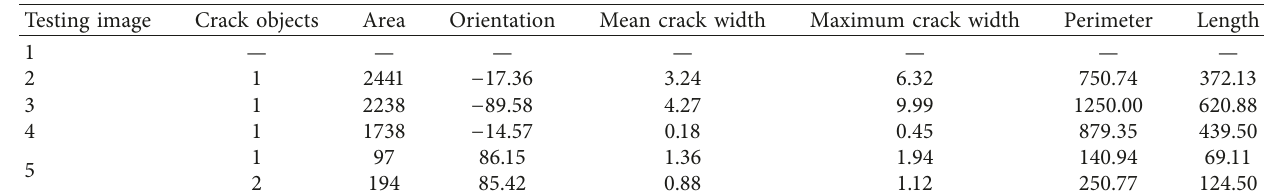
Figure 10: Testing image no. 5 using (a) the Otsu method and (b) the M2GLD method. Table 1: Results of crack